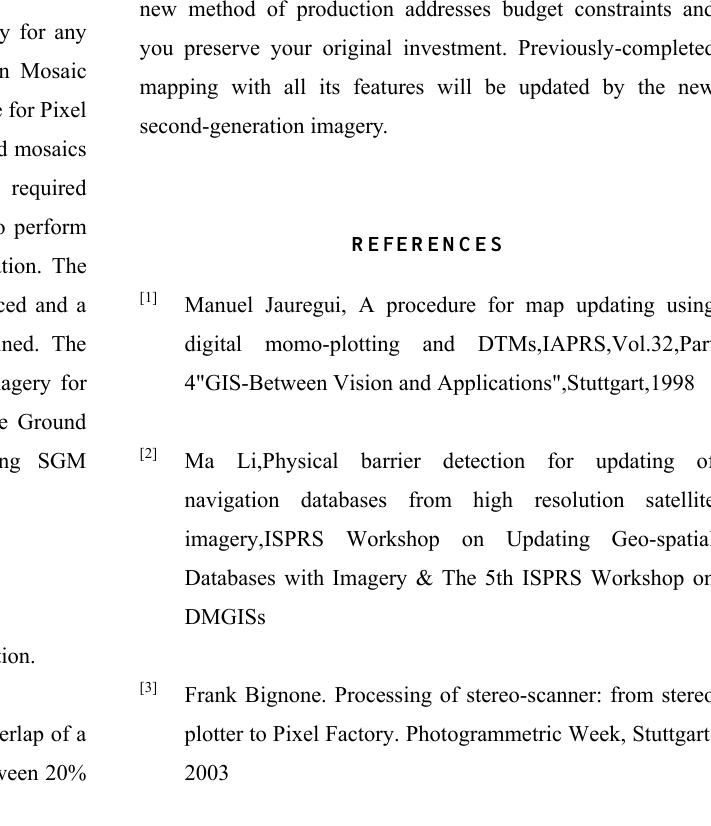
plotter to Pixel Factory. Photogrammetric Week,